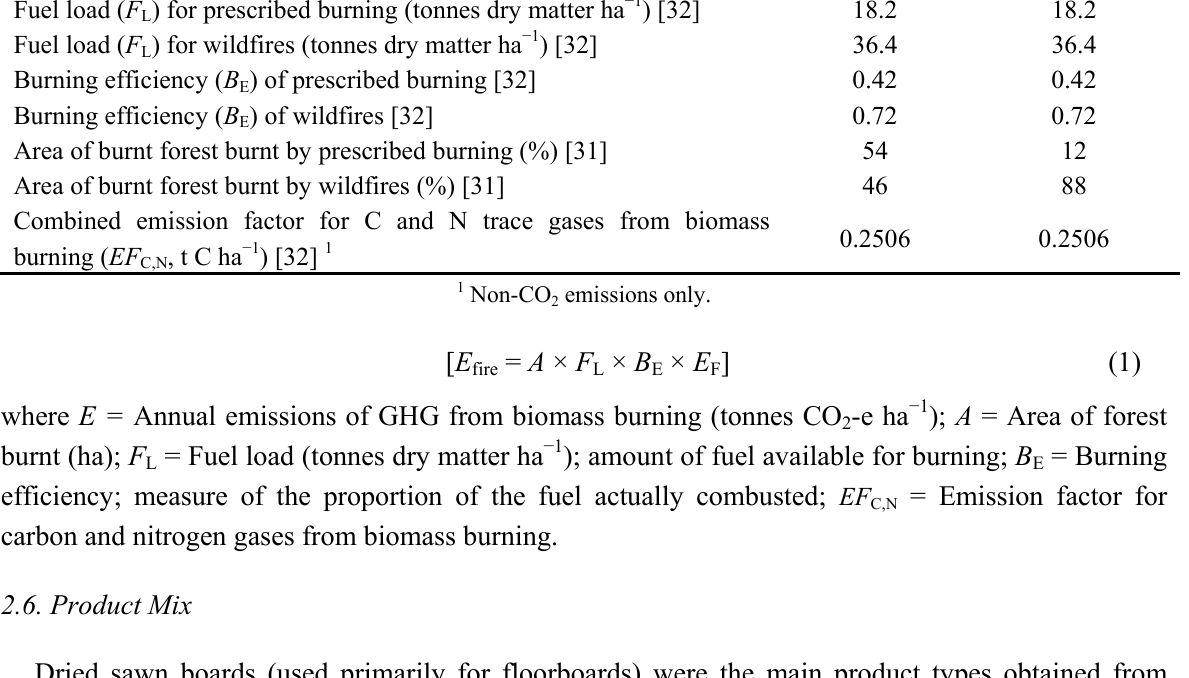
greenhouse gas (GHG) emissions (annual 2